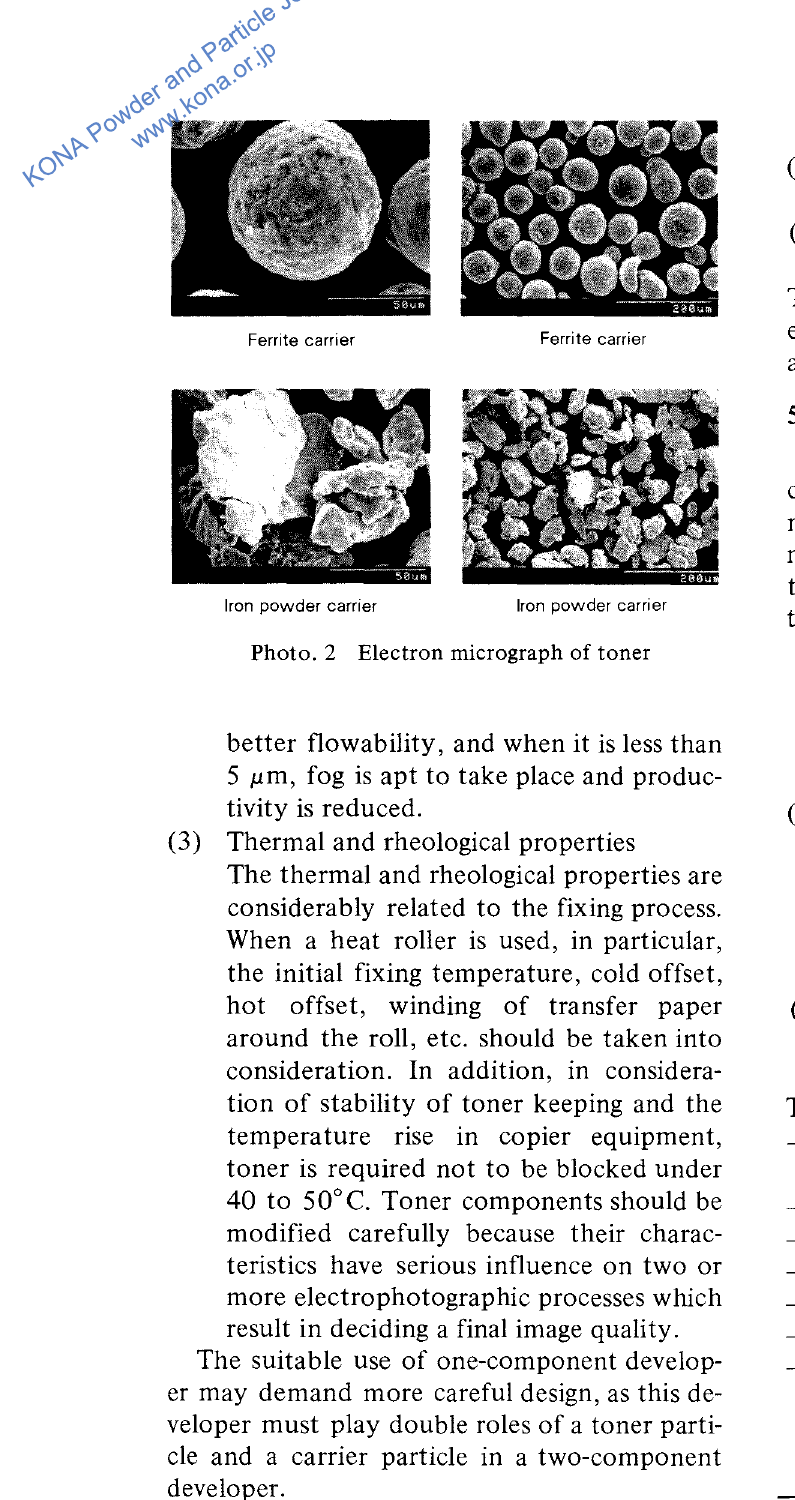
Table 3 Component of